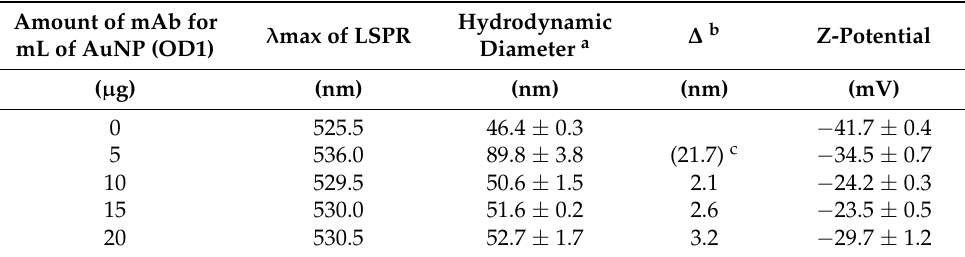
Table 3. Spectroscopic and dimensional characteristics of conjugates as a function of different amounts of mAb adsorbed on the surface of the 32 nm